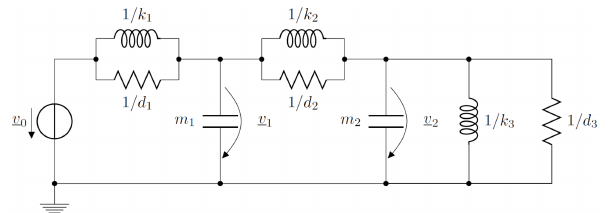
Figure 3. Electric circuit model for a co-resonant cantilever sensor whose mechanical representation is shown in Fig. 2.